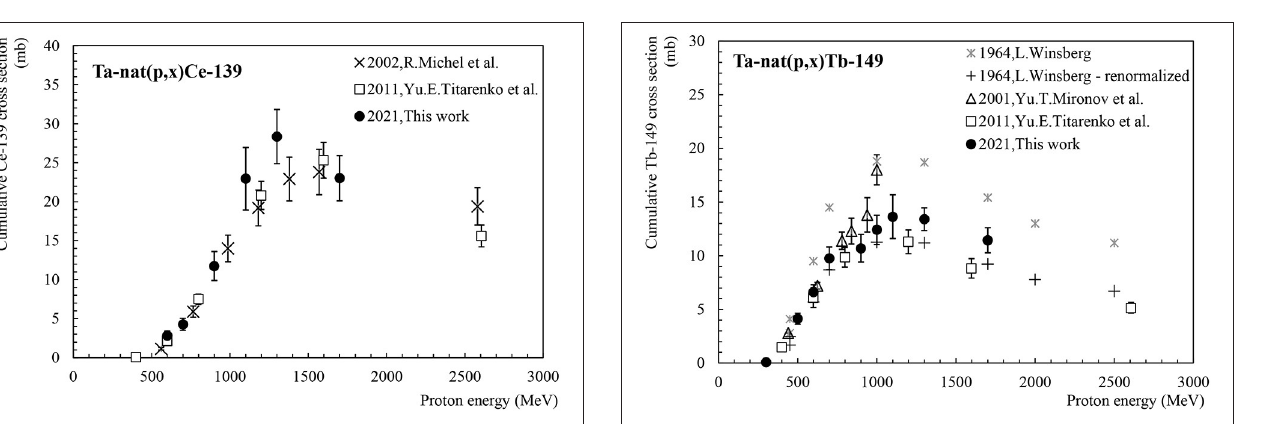
values extracted from the FitzPeaks software (22) were used to give an upper limit estimate of the production cross-section at 900 MeV and 1 GeV. The corresponding values are plotted as arrows pointing downwards in Figure 1 . The Ta-nat(p,x)Ce- 133m excitation function shows a maximum at 1.7 GeV with 5 mb.